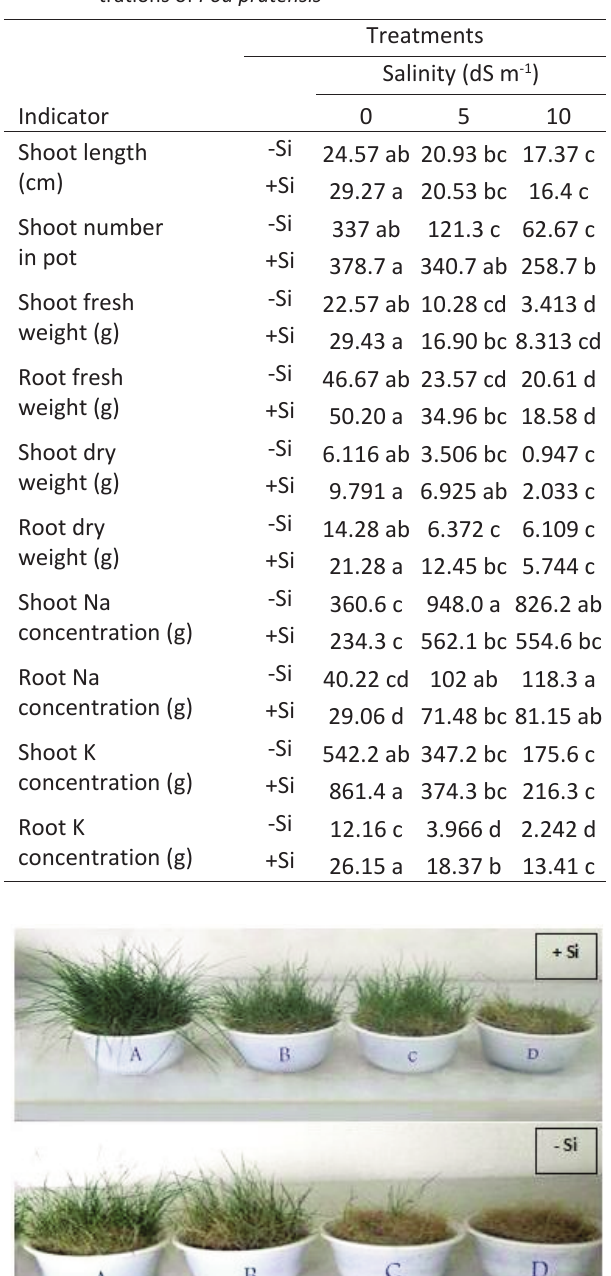
Table 1 - Interaction effects of different salinity and Si levels on growth parameters, shoot and root Na and K concen- trations of Poa pratensis